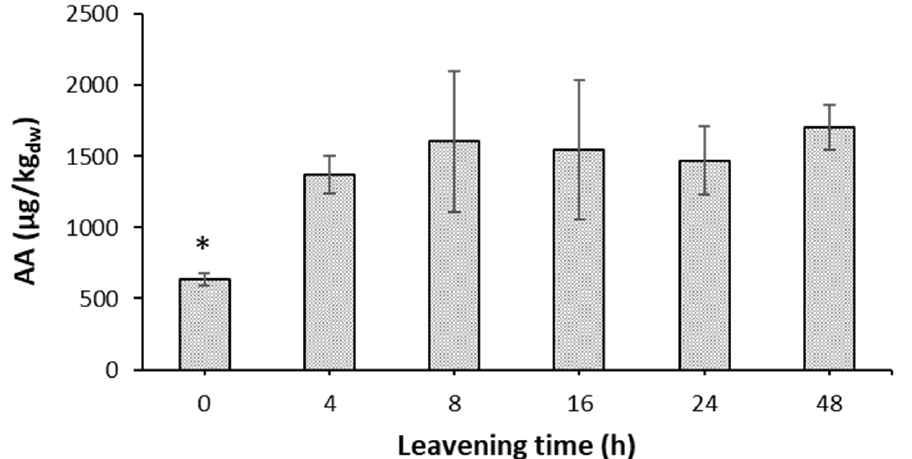
Figure 5. The AA content of a wood oven-baked pizza base leavened for 0, 4, 8, 16, 24, and 48 h. Values are mean ± SD ( n = 3). *, significantly different by ANOVA statistical test with Post Hoc Tukey ( p < 0.05).